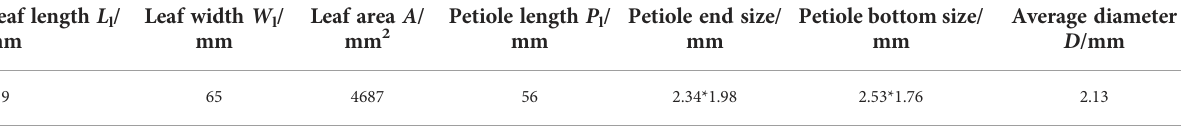
The front and back of * represent the major axis and minor axis dimensions of the petiole.